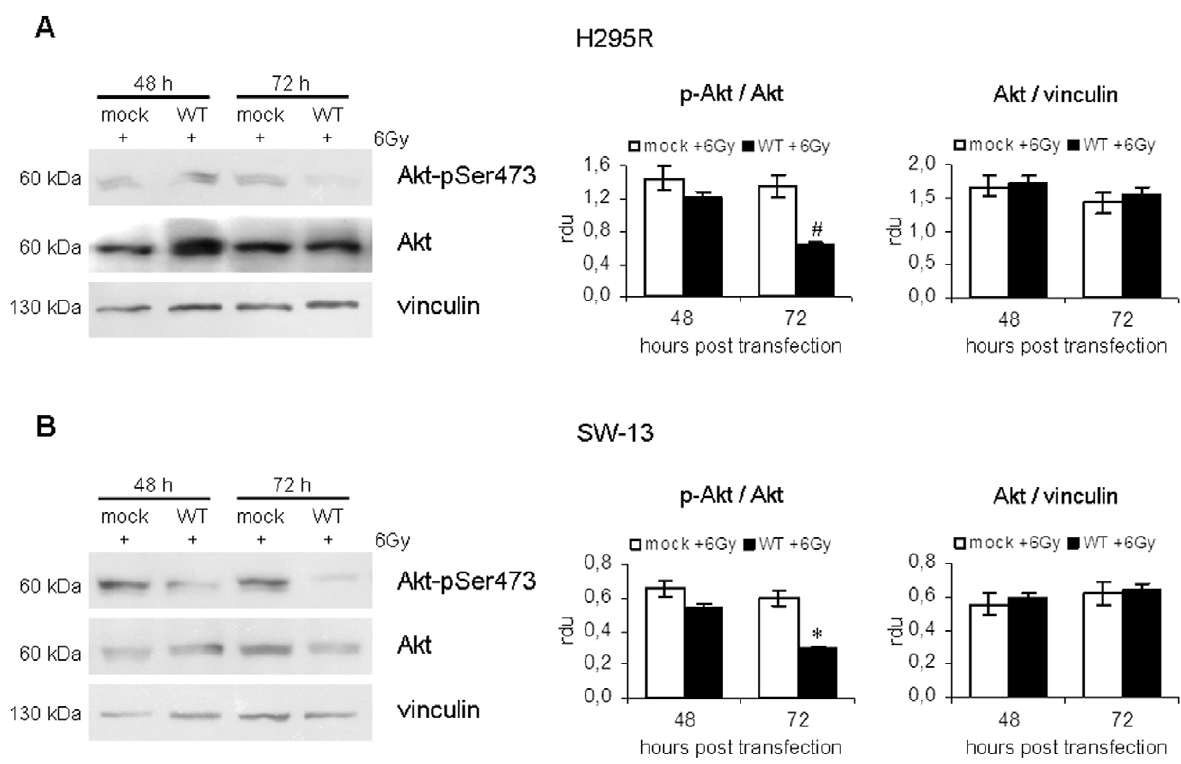
Figure 6. Effect of p53 stabilization on Akt activation after ionizing radiation treatment. (A) Western blotting analysis of total Akt and phosphorylated Akt levels, performed on irradiated H295R cells transfected with empty vector (mock) and p53-vector (WT) at 48 and 72 h after transfection. Densitometric analysis of Akt normalized to vinculin and p-Akt versus Akt shows that Akt expression is not influenced by p53 status, while the activated form of the protein is significantly reduced in wt p53-expressing cells. (B) Total cell lysates obtained from SW-13 cell line were subjected to Western blotting analysis using antibodies targeting Akt and Akt-pSer473. Phosphorylation levels of Akt are significantly reduced by p53 stabilization in response to ionizing radiation treatment. Results shown are representative of at least three experiments. Bands’ intensities were quantified using ImageJ and bands’ densitometry is shown in the right panels. (*, p , 0.05; # , p , 0.01).